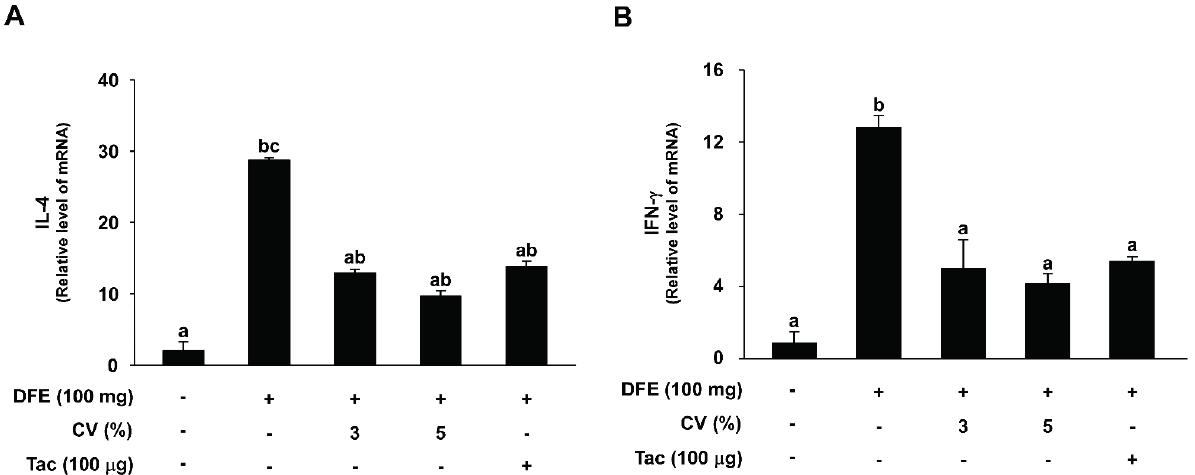
Figure 5. Effect of CV on DFE-induced increases in cytokine mRNA levels. IL-4 ( A ) and IFN- γ ( B ) mRNA levels were analyzed by real-time quantitative RT-PCR. Data represent the mean values ± SEM ( n = 6). Means with letters (a–c) within a graph are significantly different from each other at p <